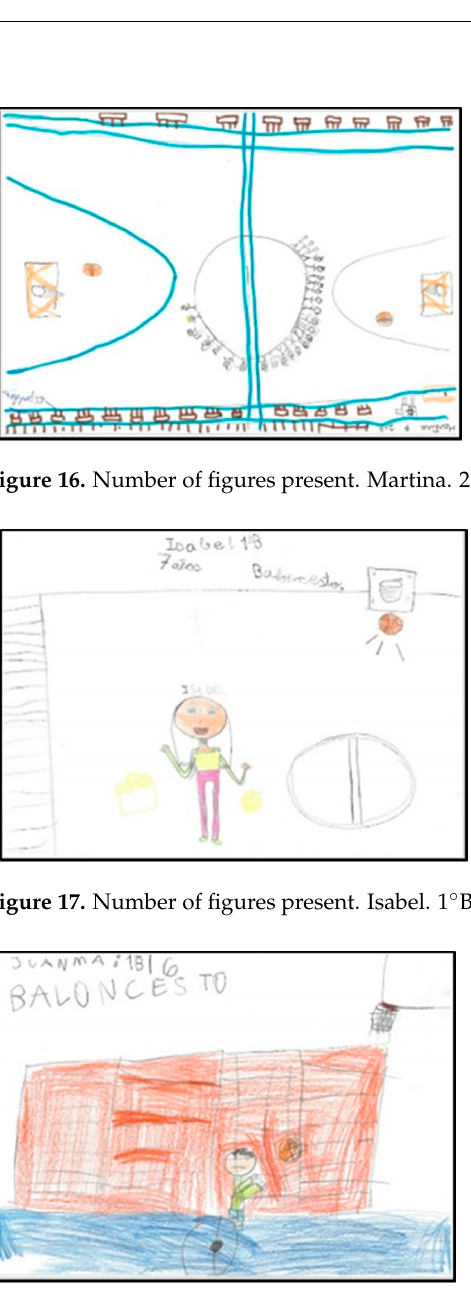
Figure 15. Number of figures present. Laura. 2°B.